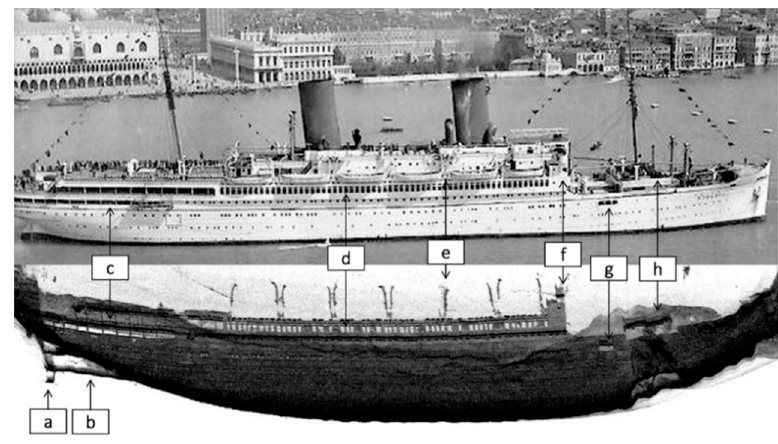
Figure 13. Comparison of the recorded sonar data with the photographic documentation of the ship. ( a ) propeller; ( b ) shaft; ( c ) pillars and stern decks; ( d ) sixty rectangular side windows; ( e ) six pairs of boat davits; ( f ) front part of the superstructure; ( g ) hawse-holes; and ( h ) small bow superstructure.